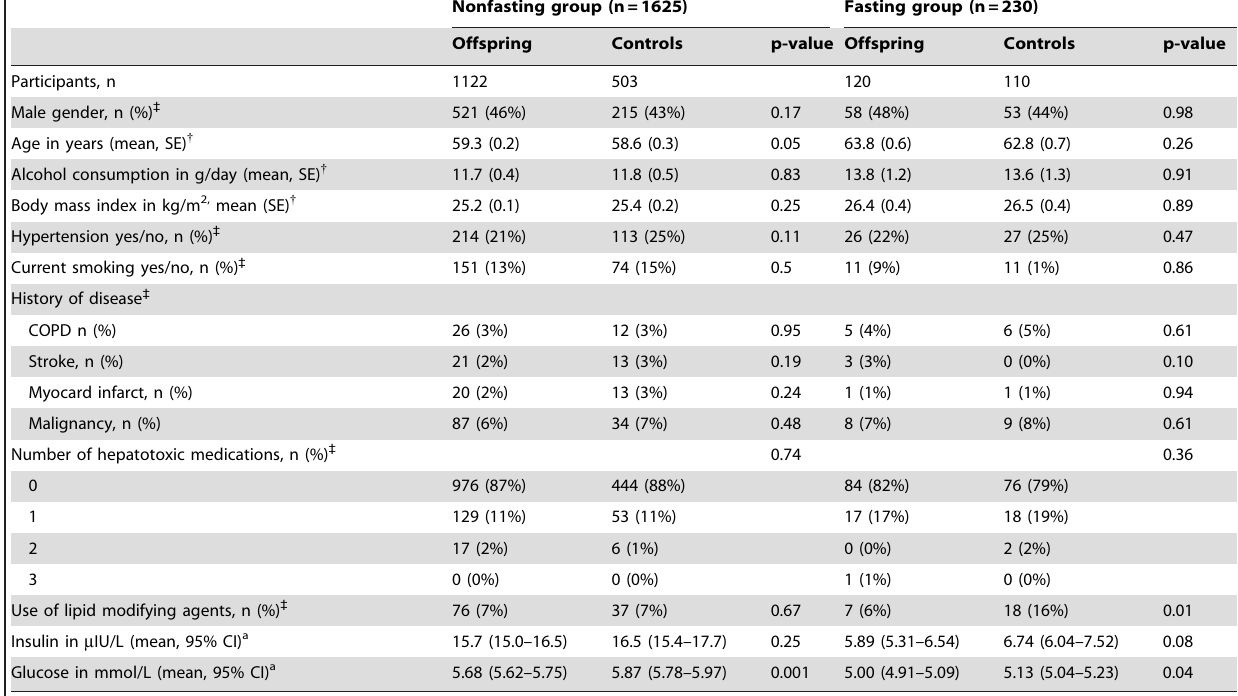
Table 1. Subject